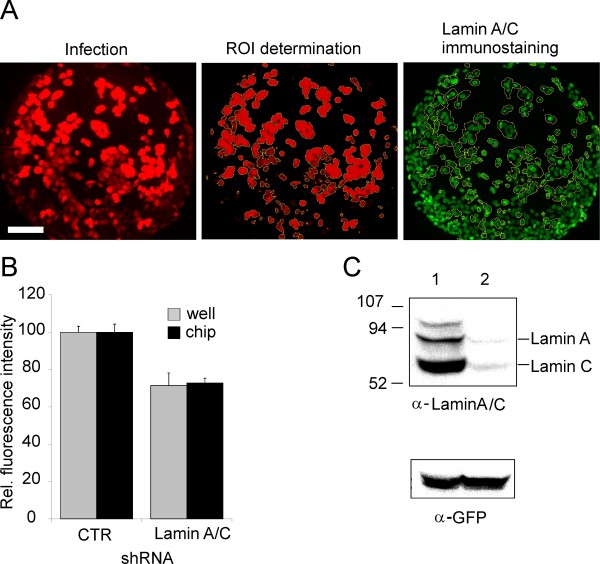
Analysis of lamin knock-down in U-2 OS cells seeded on an adenoviral microarray. A. Fluorescent micrographs of cells expressing RFP and shCTR stained with antibody directed against lamin A/C. Red fluorescence (left) indicates infected cells, green fluorescence (right) indicates lamin A/C expression. The diagram illustrates the evaluation procedure. Scale bar, 10 μm. B. Bar diagram, showing the averages of fluorescence intensity of the lamin A/C immunostaining of U-2 OS cells expressing either an irrelevant shRNA (shCTR), or shRNA directed against lamin A/C (shLamin) [5] for the experiments performed on the chip (black bars) or in the 96-well plate (gray bars). Infection efficiency achieved on the microarray as well as in the well suffices to elicit a significant knock-down (4 spots, n > 150, p < 0.005; by ANOVA analysis). C. Validation of shRNA targeting Lamin A/C by Western immunoblot analysis. U-2 OS cells were transfected either with pENTR +pcDNA3-eGFPneo (lane 1) or with pENTR-shLaminA/C +pcDNA3-eGFPneo (lane 2) and the lysates were immunoassayed 48 hours later.